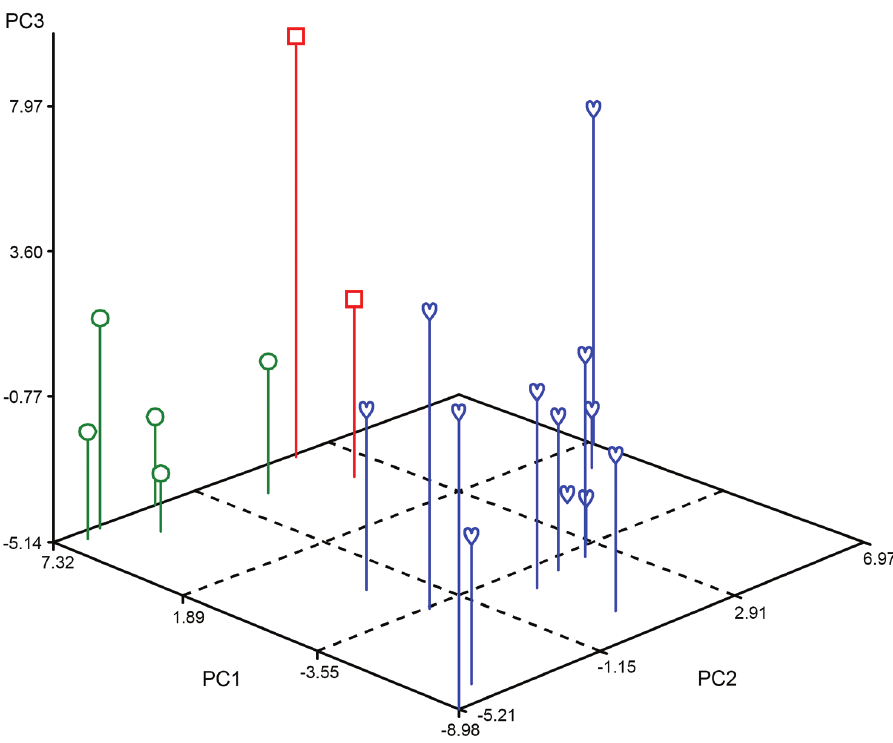
Figure 7. Principal coordinate analysis (PCoA) of 19 adult specimens of three species of Lasiochernes based on 85 morphological characters: L. cretonatus (green circles), L . jonicus (red squares) and L . pilosus (blue hearts). The first three coordinate axes explain 37.8%, 15.1% and 12.6% of the